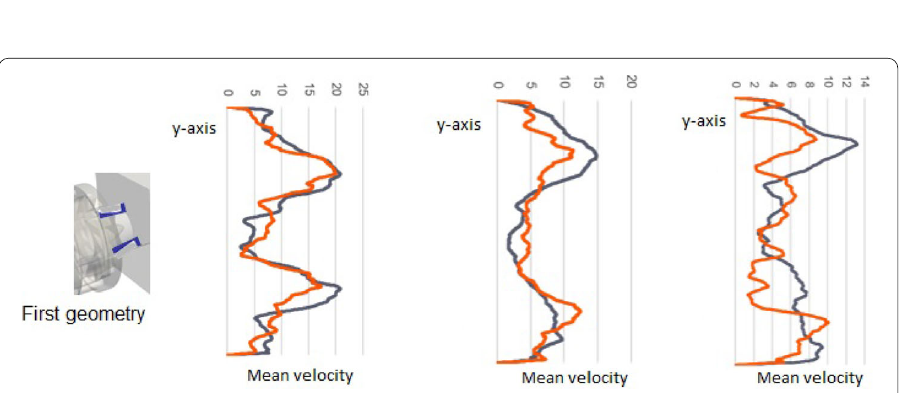
Fig. 56 G1: comparison of the recirculation zones obtained respectively as a consequence of the UGPOD in orange and the HF LES in black